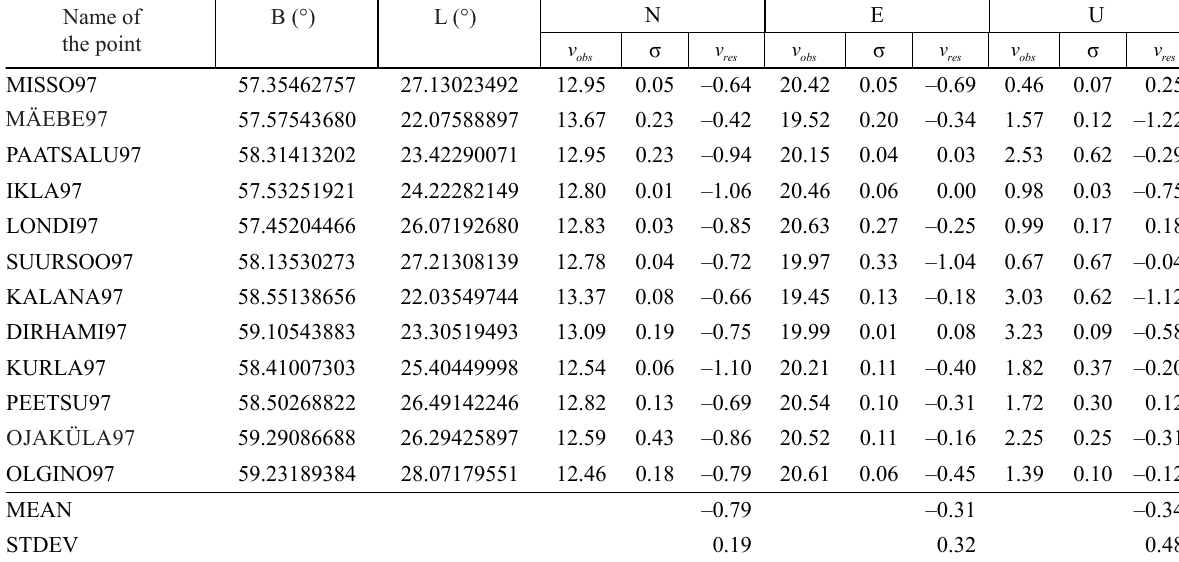
Table 5. The velocities ( ν ) of the 1st-order points of the GRN in ITRF2008 and standard deviations of the velocities (σ at 68% confidence level) in North (N), East (E) and Up (U) directions. Residual velocities were obtained according to Eq. (1) by removing the motion due to plate tectonics (model ITRF2008-PPM) and GIA (model NKG2016GIA). Unit is